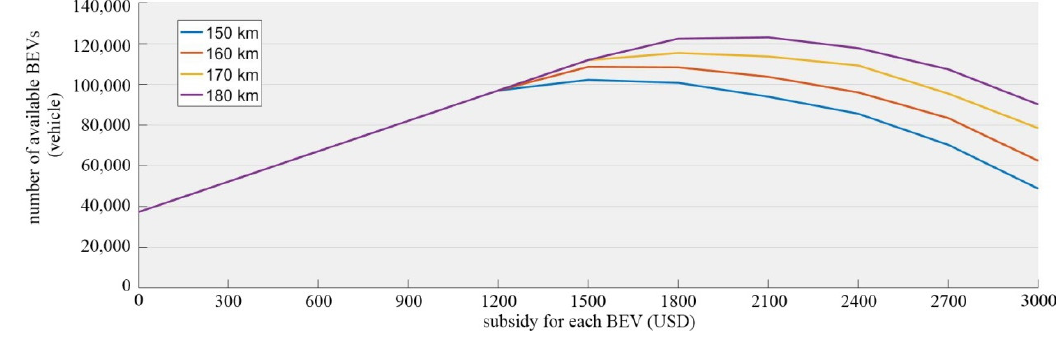
Figure 14. The results under different endurance ranges and subsidies.